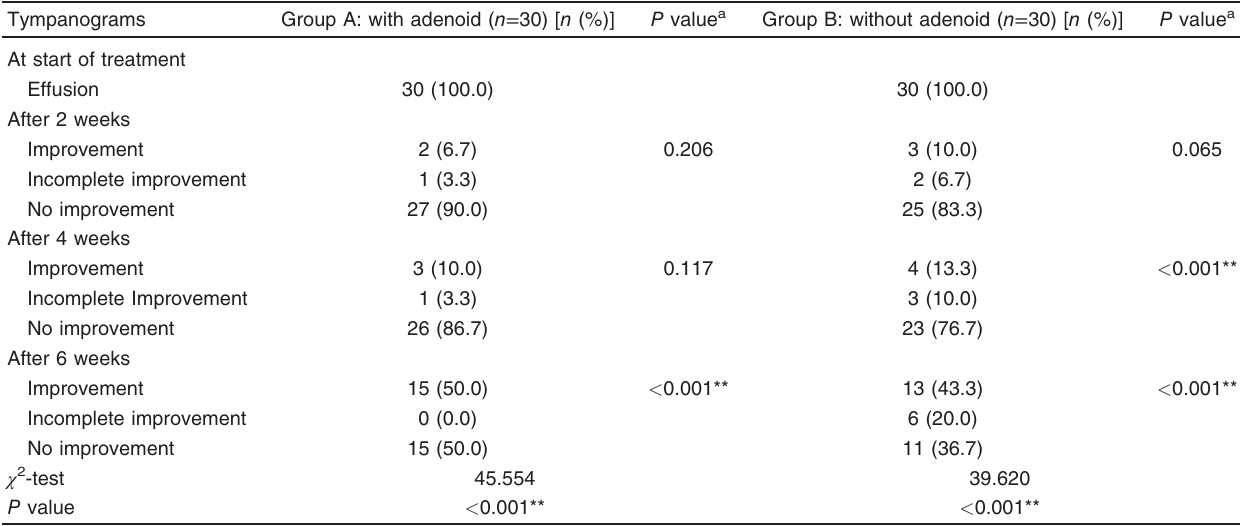
Table 6 Comparison between improvement in tympanogram through different times within each group separately Tympanograms